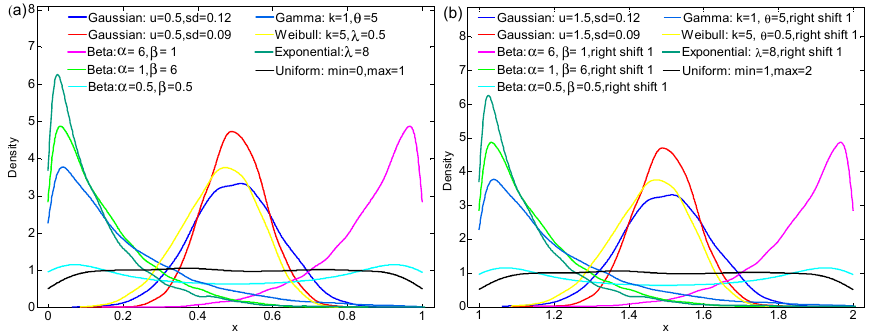
Figure 4. The PDF distribution of simulated data: ( a ) Scheme 2; ( b ) Scheme 3. Table 3. Calculation results of the three methods for the simulated data in Scheme 3.